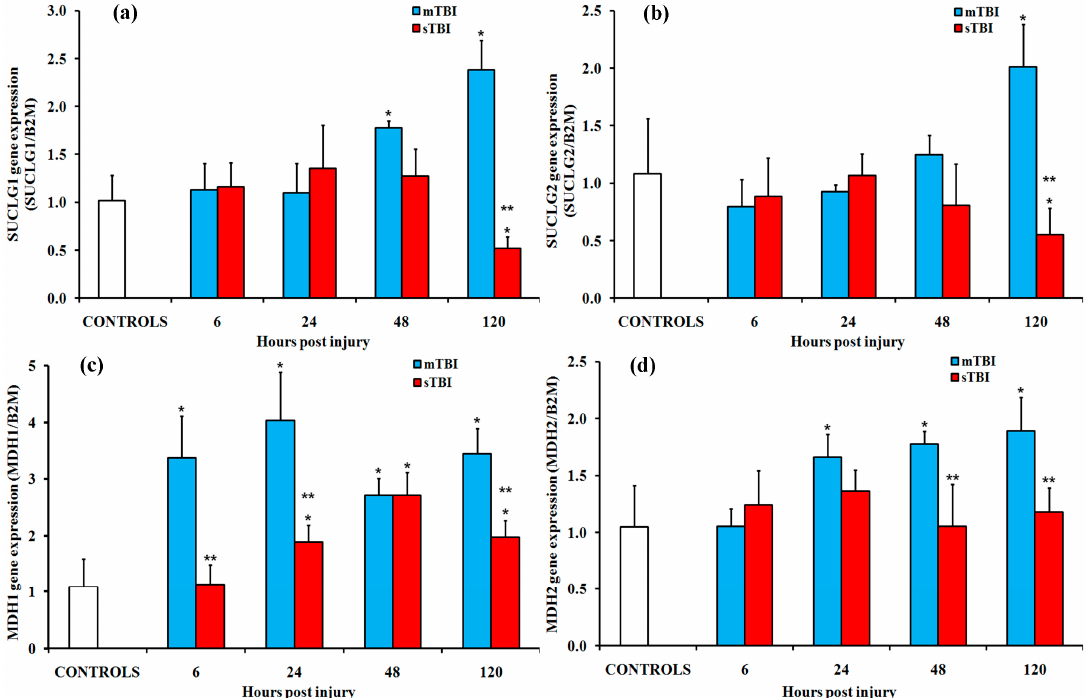
Figure 7. Changes in the expression of the genes encoding for the two subunits of succinyl-CoA ligase (SUCLG1 and 2) and of the cytoplasmic (MDH1) and mitochondrial (MDH2) isoenzymes of malate dehydrogenase (MDH) in the brain tissue homogenates of rats receiving a TBI of different severities (mTBI or sTBI) at various times post-injury. ( a ) SUCLG1, the gene encoding for the α subunit of succinyl-CoA ligase; ( b ) SUCLG2, the gene encoding for the β subunit of succinyl-CoA ligase; ( c ) MDH1, the gene encoding for the cytoplasmic MDH isoform; ( d ) MDH2, the gene encoding for the mitochondrial MDH isoform. Values are the mean of six animals. Standard deviations are represented by vertical bars. Gene expressions were calculated relative to the expression of the housekeeping gene β -2-microtubulin (B2M). * significantly different from the controls, p < 0.05. ** significantly different from the corresponding time of the mTBI rats, p < 0.05.